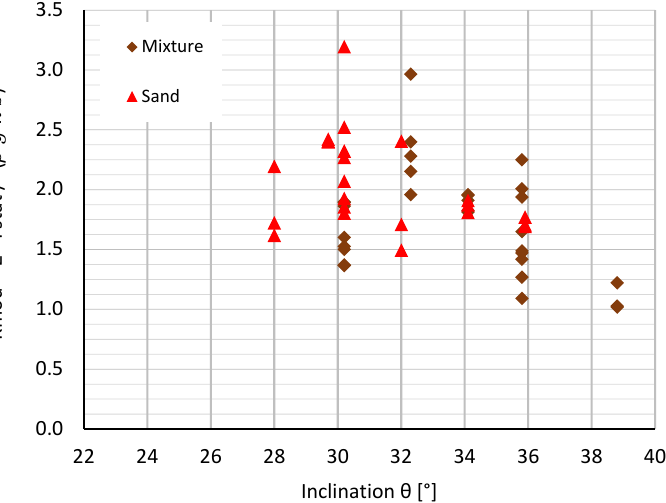
Figure 16. Back-calculated creep pressure coefficients K mod for the sand and mixture test materials on the rigid barrier based on Equation (16).